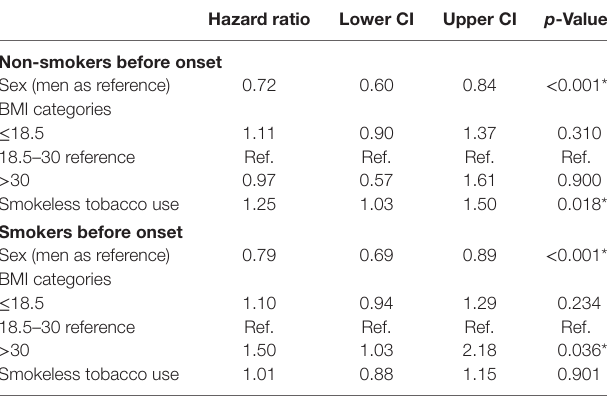
TaBle 3 | Cox regression summary for smokers ( n = 3,282, 1,227 events) and non-smokers ( n = 2,316, 772 events). hazard